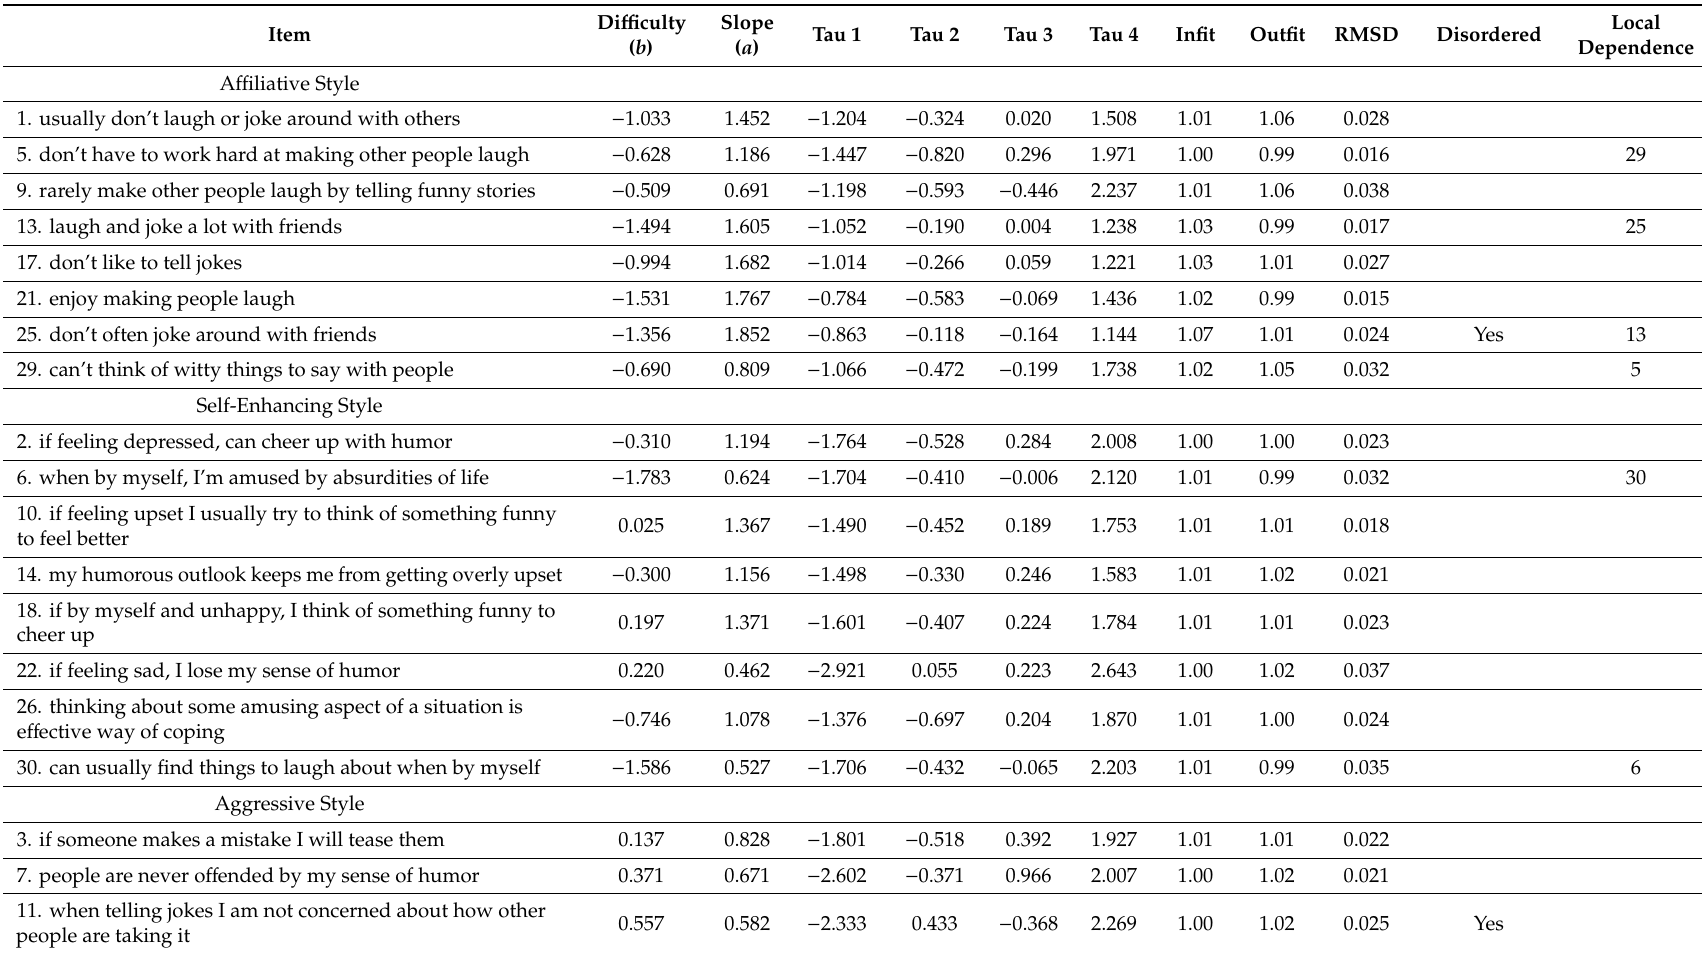
Table 1. Humor styles questionnaire: Abbreviated item stems and psychometric